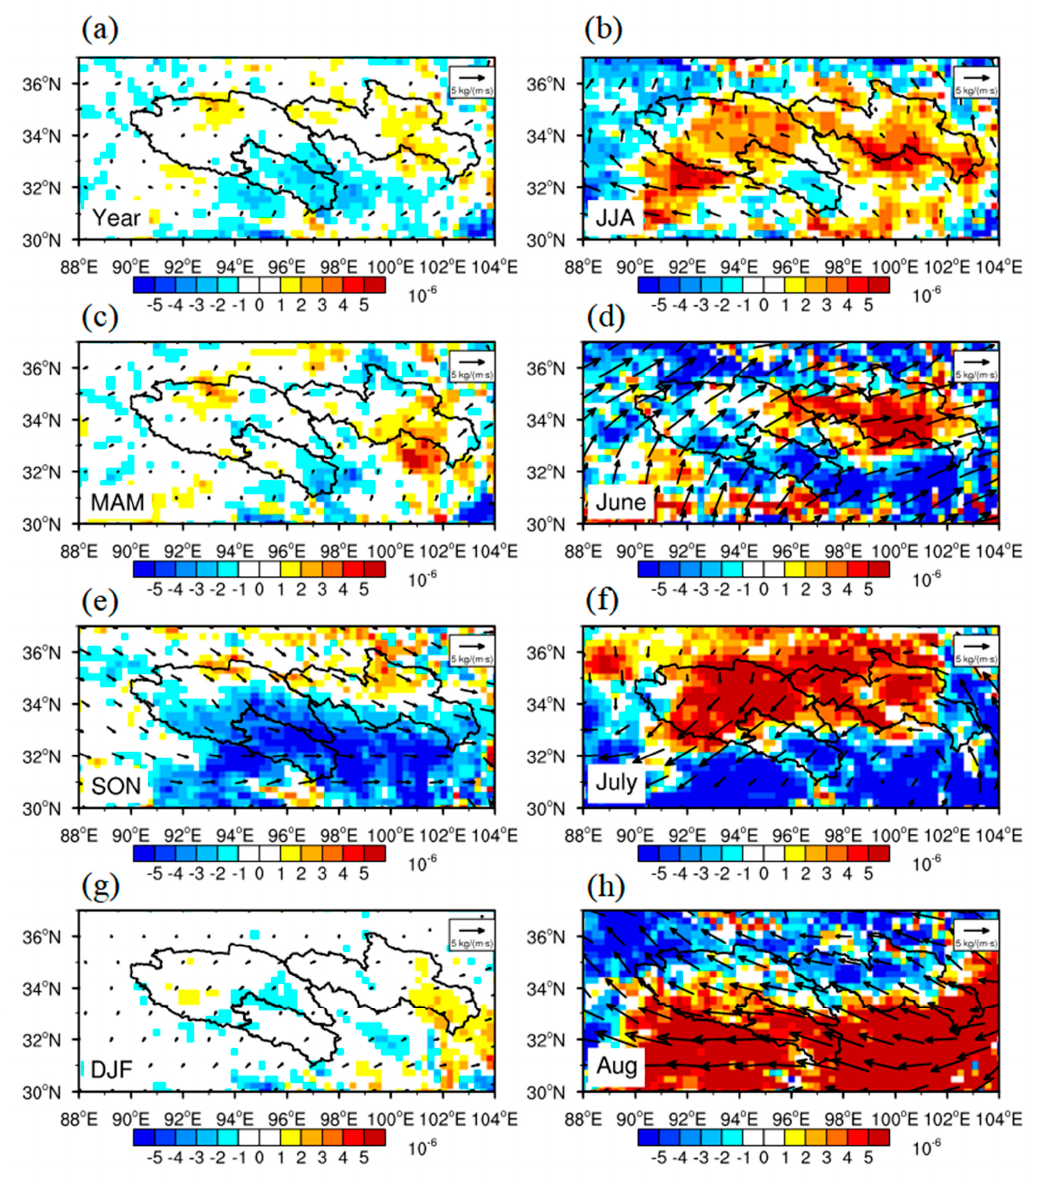
Figure 10. Differences between climatology of vertical water vapor (Vectors, kg/(m.s)) and its divergence (Shaded, kg/(m 2 .s)) in ( a ) annual average, ( b ) June-July-August (JJA) average, ( c ) March-April- May (MAM) average, ( d ) June average, ( e ) September-October-November (SON) average, ( f ) July average, ( g ) December-January-Februrary (DJF) average, and ( h ) August average from 2010 to 2019 and 2001 to 2010.